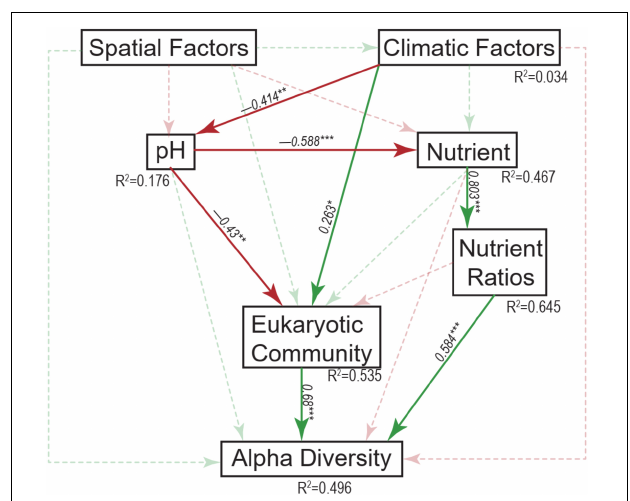
FIGURE 4 | Structural equation modeling analysis depicting the relationships between spatial factors (including latitude, longitude, and elevation), climatic factors (including mean annual temperature and mean annual precipitation), pH, nutrients (including sediment organic carbon, total nitrogen, and total phosphorus), nutrient ratios (including C:N, C:P, and N:P ratios), micro-eukaryotic community, and alpha diversity. Solid and dashed arrows represent the significant and non-significant relationships, respectively. Red and green arrows represent negative and positive relationships, respectively. The significant path coefficients were shown adjacent to the path with *, **, and *** denote the significant level of p < 0.05, p < 0.01, and p < 0.001,